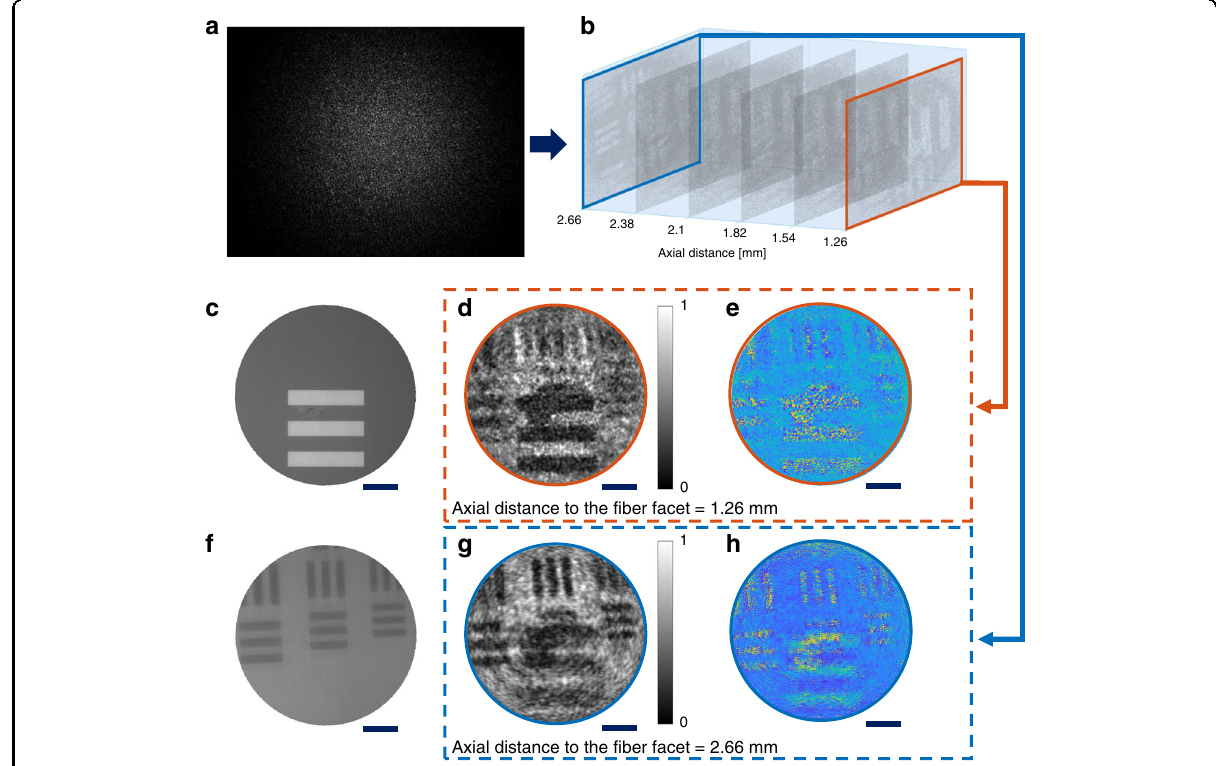
Fig. 3 Reconstruction of a multi-layer target, which consists of two test targets located at 1.26 and 2.66 mm away from the facet at the measurement side. a Speckle pattern of the multi-layer target captured on the detection camera. b Reconstructed amplitude slides of the sample at different axial distances. c Image of the top layer from a bulky re fl ective microscope. d , e Reconstructed d amplitude and e phase image of the top layer, the linewidth is 22.1 μ m. f Image of the bottom layer from a bulky re fl ective microscope. g , h Reconstructed g amplitude and h phase image of the bottom layer, the linewidths are 11.05, 9.84, and 8.77 μ m respectively. Scale bars 50 μ